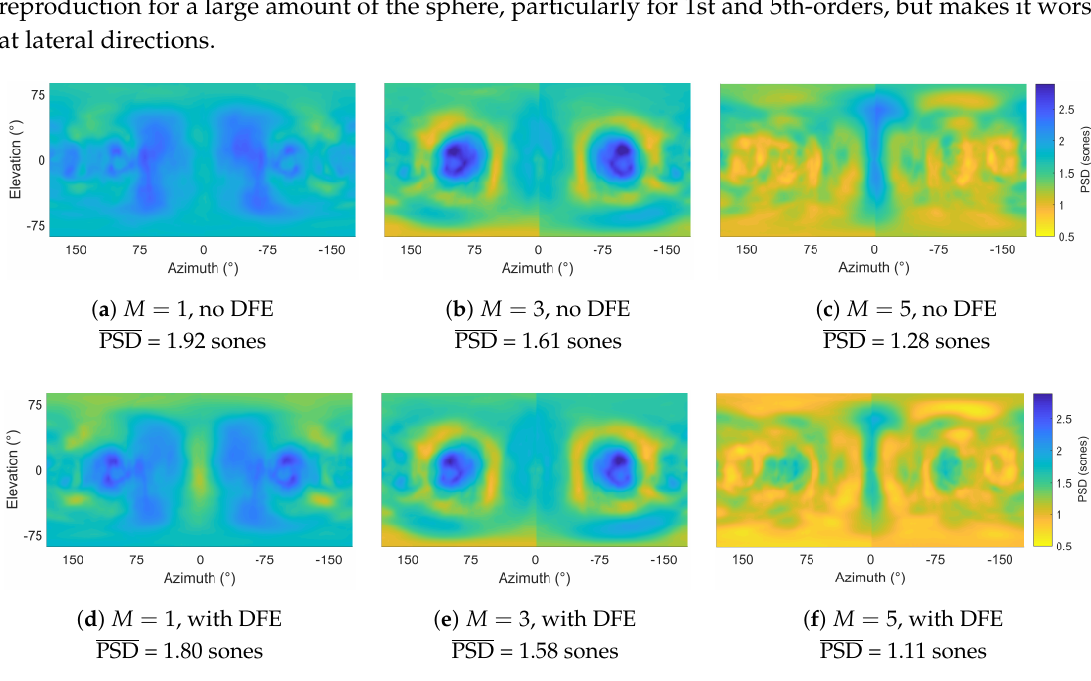
Figure 6. PSD between HRTFs and reference HRTFs with and without DFE (mean of left and right ear PSD calculations): ( a ) M = 1, no DFE, ( b ) M = 3, no DFE, ( c ) M = 5, no DFE, ( d ) M = 1, with DFE, ( e ) M = 3, with DFE and ( f ) M = 5, with DFE. PSD: Perceptual spectral difference; HRTF: Head-related transfer function; DFE: Diffuse-field